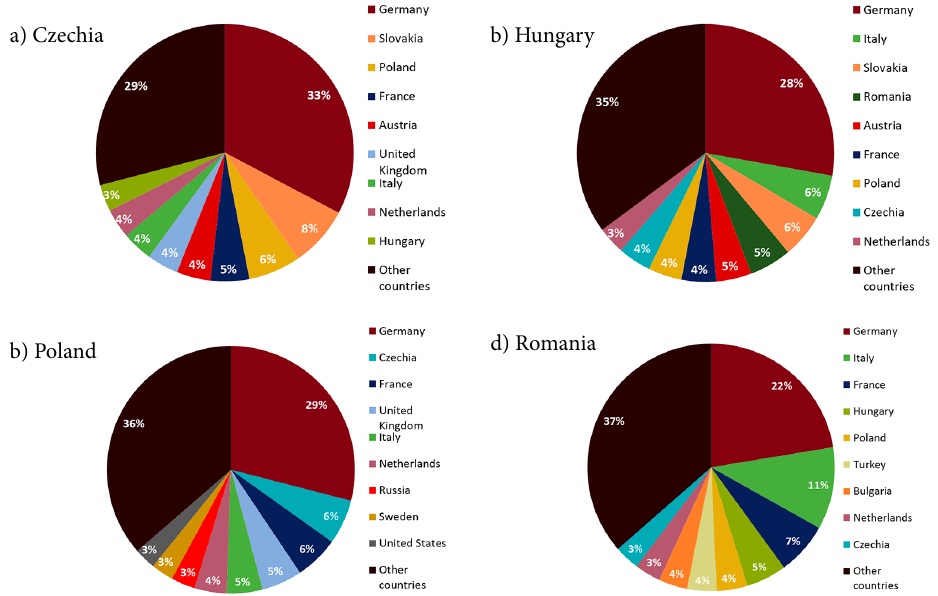
Figure A.1. Exports structure on main trade partners after the first 7 months of 2021 (12 months cumulated data) (source: Eurostat, authors’ calculations)